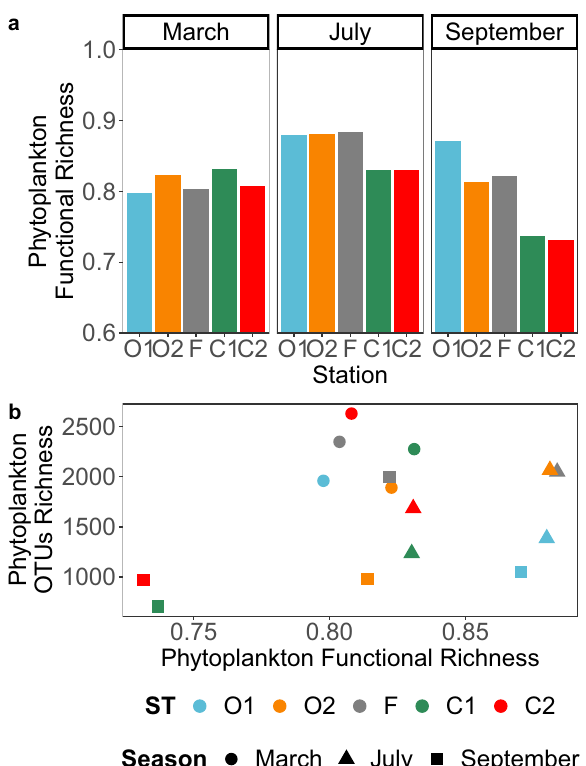
Figure 6. Patterns of eukaryotic phytoplankton functional richness in the Iroise Sea in 2015. ( a ) Functional richness was computed based on the phytoplankton OTUs (7106) present in each station (3) and each season (3) that were annotated with 12 biological traits. The trait annotation was carried out during a previous literature survey 43 , and the metric was calculated by following reference 61 . ( b ) Pairwise comparisons of phytoplankton functional richness and taxonomic richness (OTUs) in our